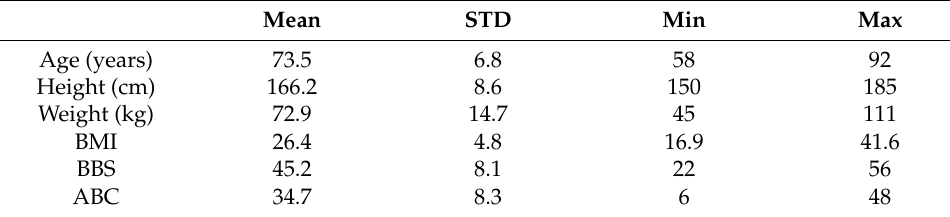
Table 2. Descriptive statistics of the 91 participants (64 females) with valid